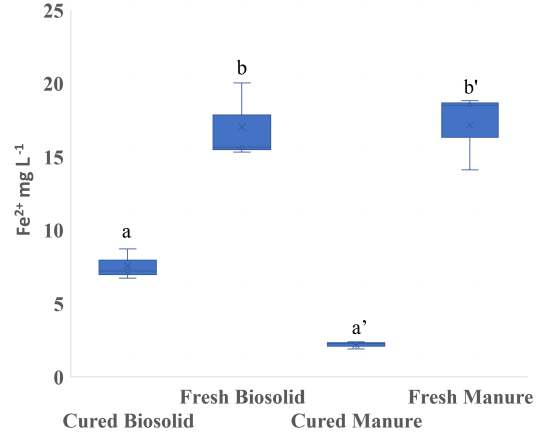
Figure 5. Experiment 2b. Concentration of ferrous iron (Fe 2 + ) in the liquid phase at the end of the incubation period (13d). Incu- bation was carried out in sandy loam. Different letters indicate a difference at p <